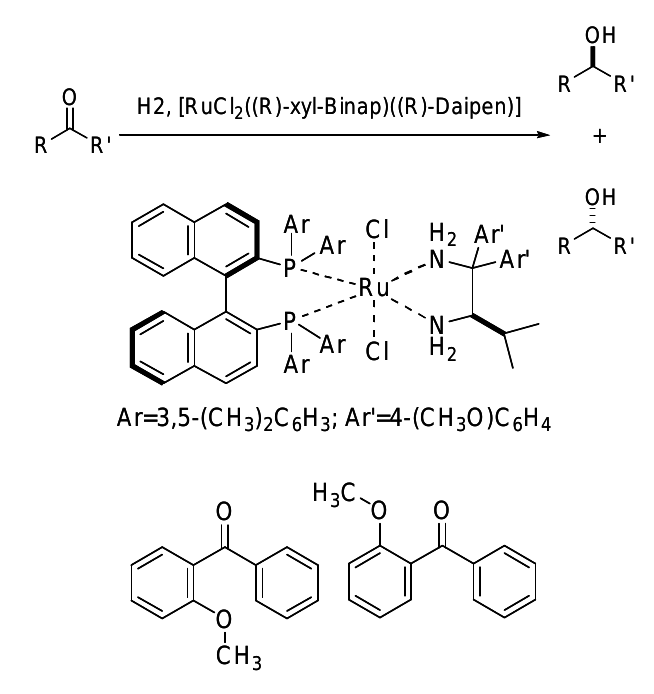
Figure 7 . a. Asymmetric catalytic ketone reduction and Noyori catalyst studied in the work of Johannes B. van der Linden et al . b. The conformations of benzophenone for the initial model (left) and the improved model